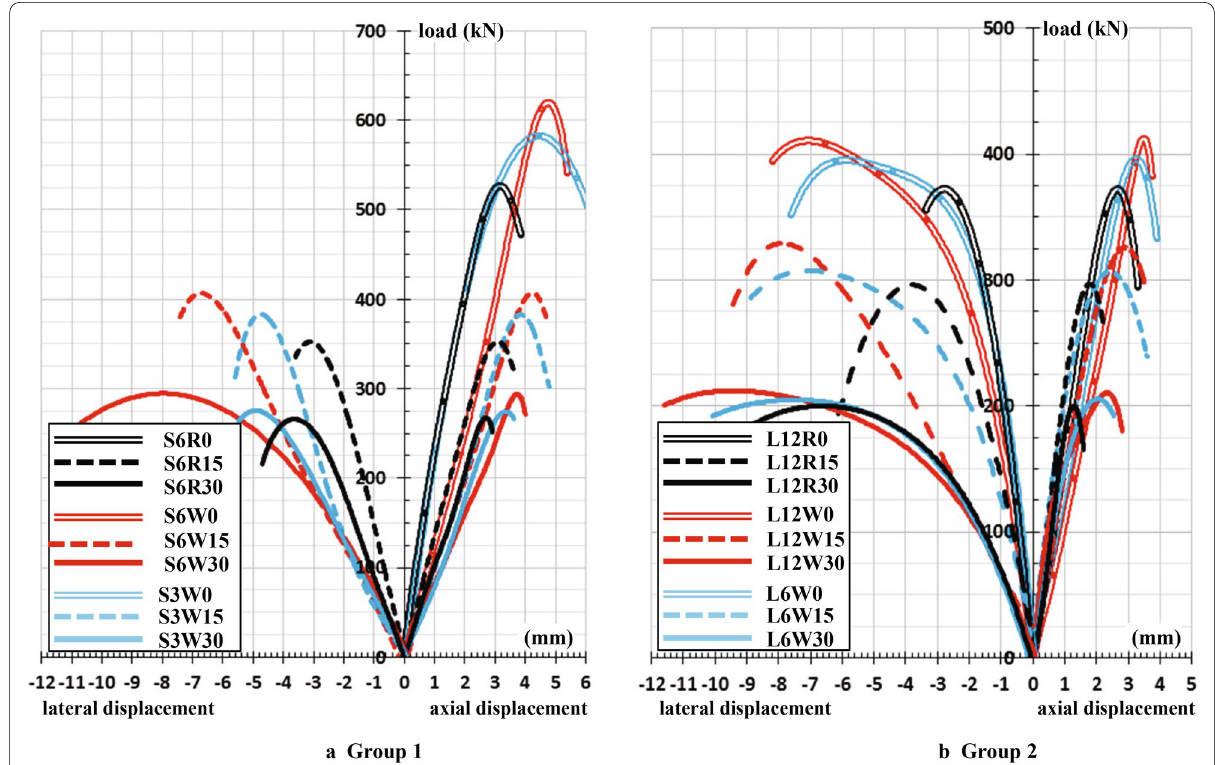
Fig. 10 Load–displacement curves for tested